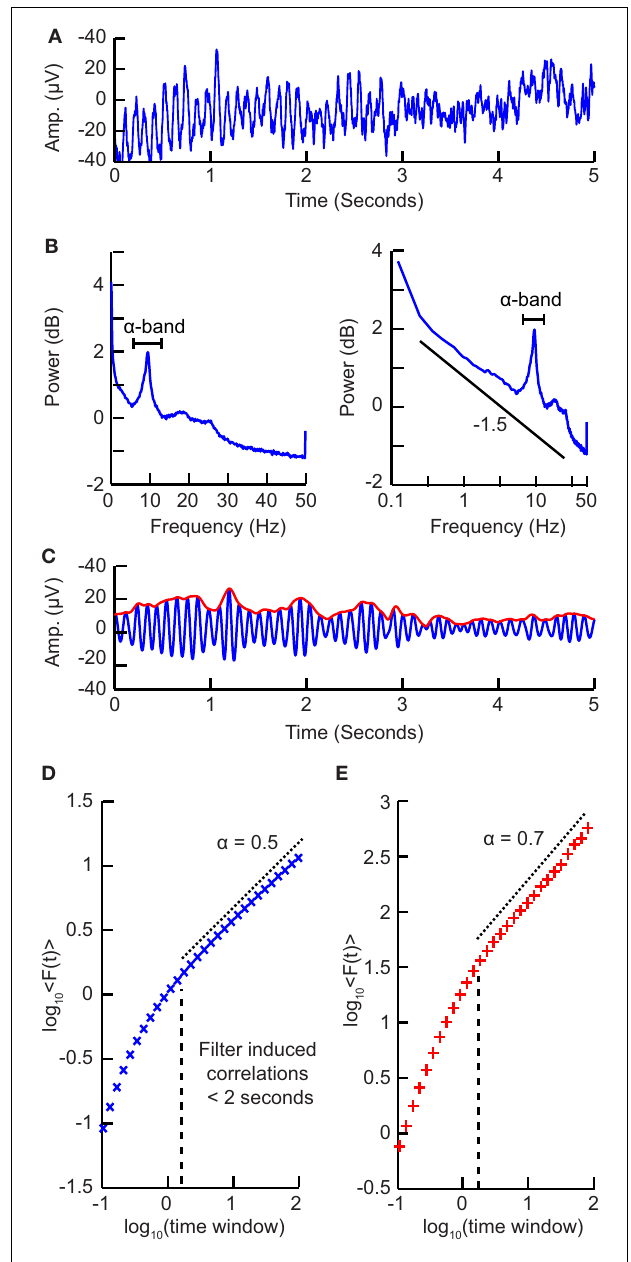
FIGURE 6 | Step-wise explanation of applying DFA to neuronal oscillations. (A) EEG recording from electrode Oz shows clear oscillations during a 15min eyes-closed rest session. Data were recorded at 250Hz and band-passed filtered between 0.1 and 200Hz. (B) Power spectrum (Welch method, zero padded) shown in logarithmic (left) and double-logarithmic axes (right), shows clear peak in the alpha band. (C) Signal in (B) filtered in the alpha band (8–13Hz) using a fir filter with an order corresponding to the length of two 8Hz cycles ( blue ). Amplitude envelope ( red ) calculated using the Hilbert transform. (D) DFA applied to the amplitude envelope of white-noise signal filtered using the same filter as in (C) . At time windows < 2s, filter-induced correlations are visible through a bend away from the 0.5 slope. (E) DFA applied to the amplitude envelope of the alpha band filtered EEG signal shows long-range temporal correlations between 2 and 90s with exponent α =